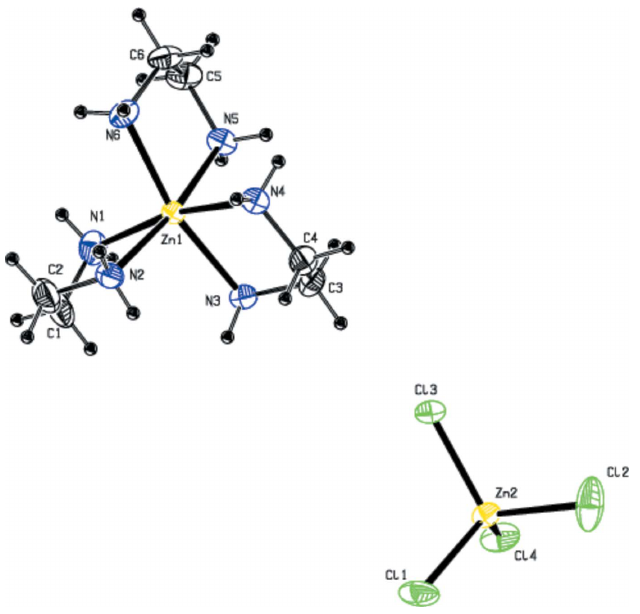
Figure 1 View of the molecular structure of the title complex, showing the atom labelling. Displacement ellipsoids are drawn at the 30% probability